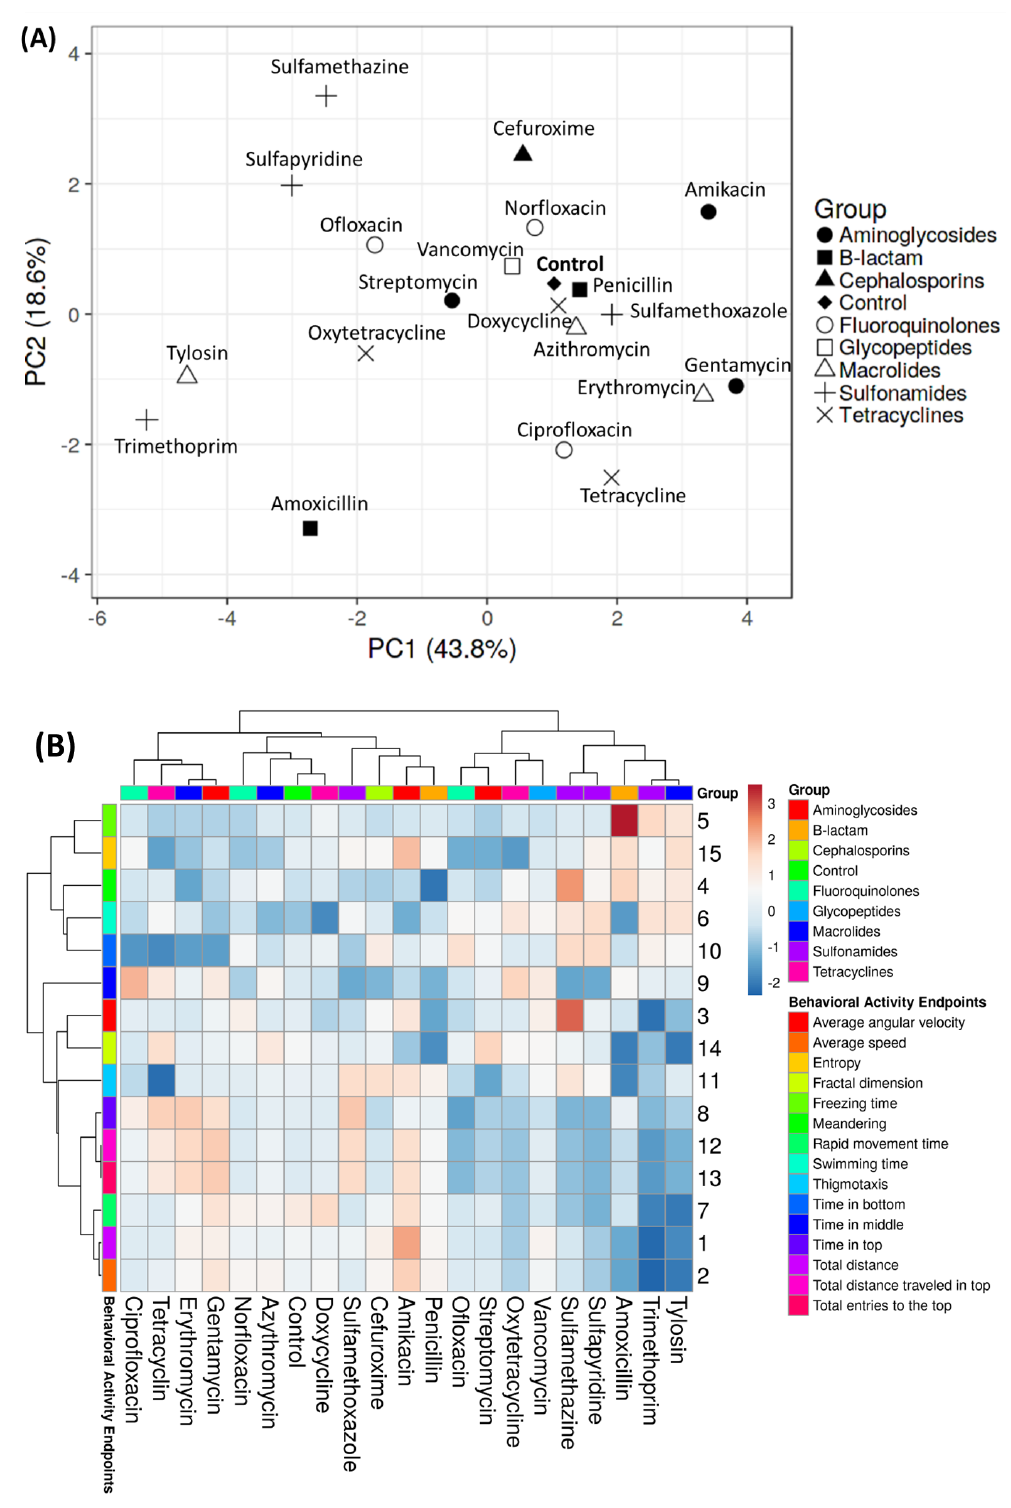
Figure 5. Principal component (PCA) and hierarchical clustering analysis based on multiple behavior endpoints in golden zebrafish after 10 days exposure to different antibiotics. ( A ) PCA projects all behavior endpoints to explore the relationships in data among the antibiotic-treated/non-treated group. ( B ) Hierarchical clustering analysis of different behavior activity post-antibiotic treatment groups. Red indicates higher score of behavior endpoint, whereas blue indicates lower score of behavior endpoint. 3.4. Data Validation for Three Selected Antibiotics of Amoxicillin, Trimethoprim and Tylosin Based on PCA and heatmap clustering results, three antibiotics, namely Amoxicillin (AMX), Trimethoprim (TMP), and Tylosin (TYL), were selected to conduct further studies due to their unique feature. Zebrafish were exposed to a low dose of either 1 or 10 ppb levels to determine whether such a trace amount of antibiotics could still induce locomo- tion and exploratory behavior changes. From the total distance activity and average speed, only AMX 1 ppb caused a significantly increased value ( p = 0.0004 and p = 0.0003, respectively) compared to the control group (Figure 6A,B). Meanwhile, TYL at 1 ppb ( p = 0.0021) and 10 ppb ( p = 0.0429) induced a significant increase in average angular velocity when compared to the control (Figure 6C). Changes in movement patterns were also ob- served in the antibiotic-treated groups, characterized by the alteration in meandering movement. The AMX at 1 ppb ( p < 0.0001), AMX at 10 ppb ( p = 0.0034) and TMP at 10 ppb ( p = 0.0416) significantly decreased the meandering degree compared to the control (Fig- ure 6D). Regarding the swimming movement behavior, most of the low-dose antibiotic groups significantly reduced the freezing time movement (Appendix A Figure A2A). At the same time, only AMX at 1 ppb significantly increased the rapid movement time ratio (Appendix A Figure A2C).